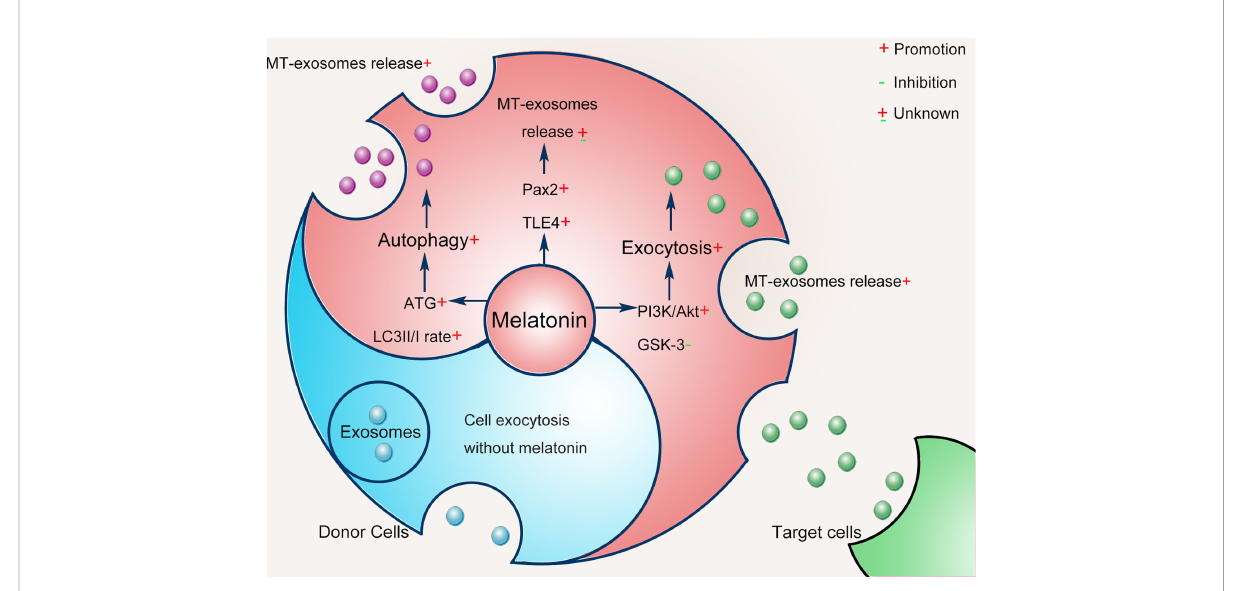
FIGURE 3 Possible mechanisms of melatonin pretreatment on exosomes: cell exocytosis and